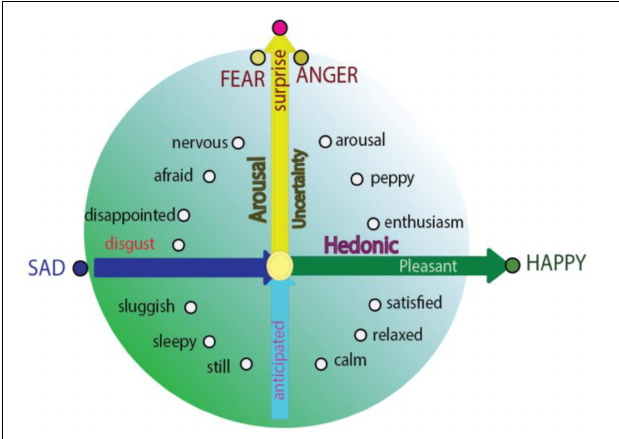
FIGURE 2 | Integrative model for basic emotions and construction approach (dimension theory). Integrative model of emotion proposed that the basic emotions are on the specific locations in the circle of the circumplex; and they are typical emotions which have only one features of core affects: Fear and anger are only related to the safety value of the stimulus , while sadness and joy are only related to the hedonic value of a stimulus; or the “basic emotion” fear and anger have no hedonic value and happiness and sadness have no safety value (Zheng et al., 2016).